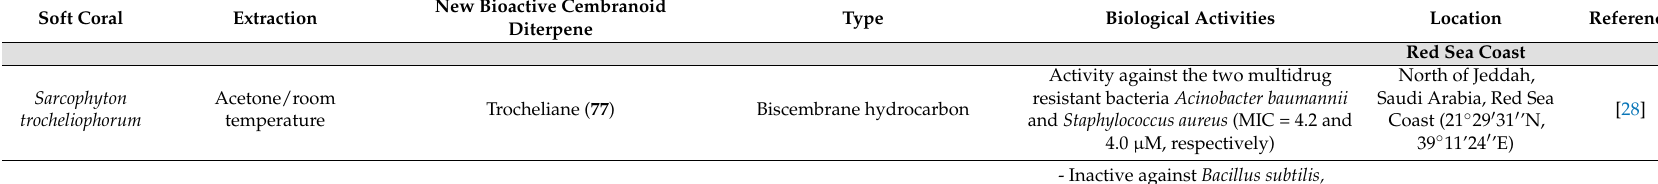
Table 2. Harvesting locations of the soft corals of the genus Sarcophyton , extraction solvent, new compounds identified and their biological properties. Soft